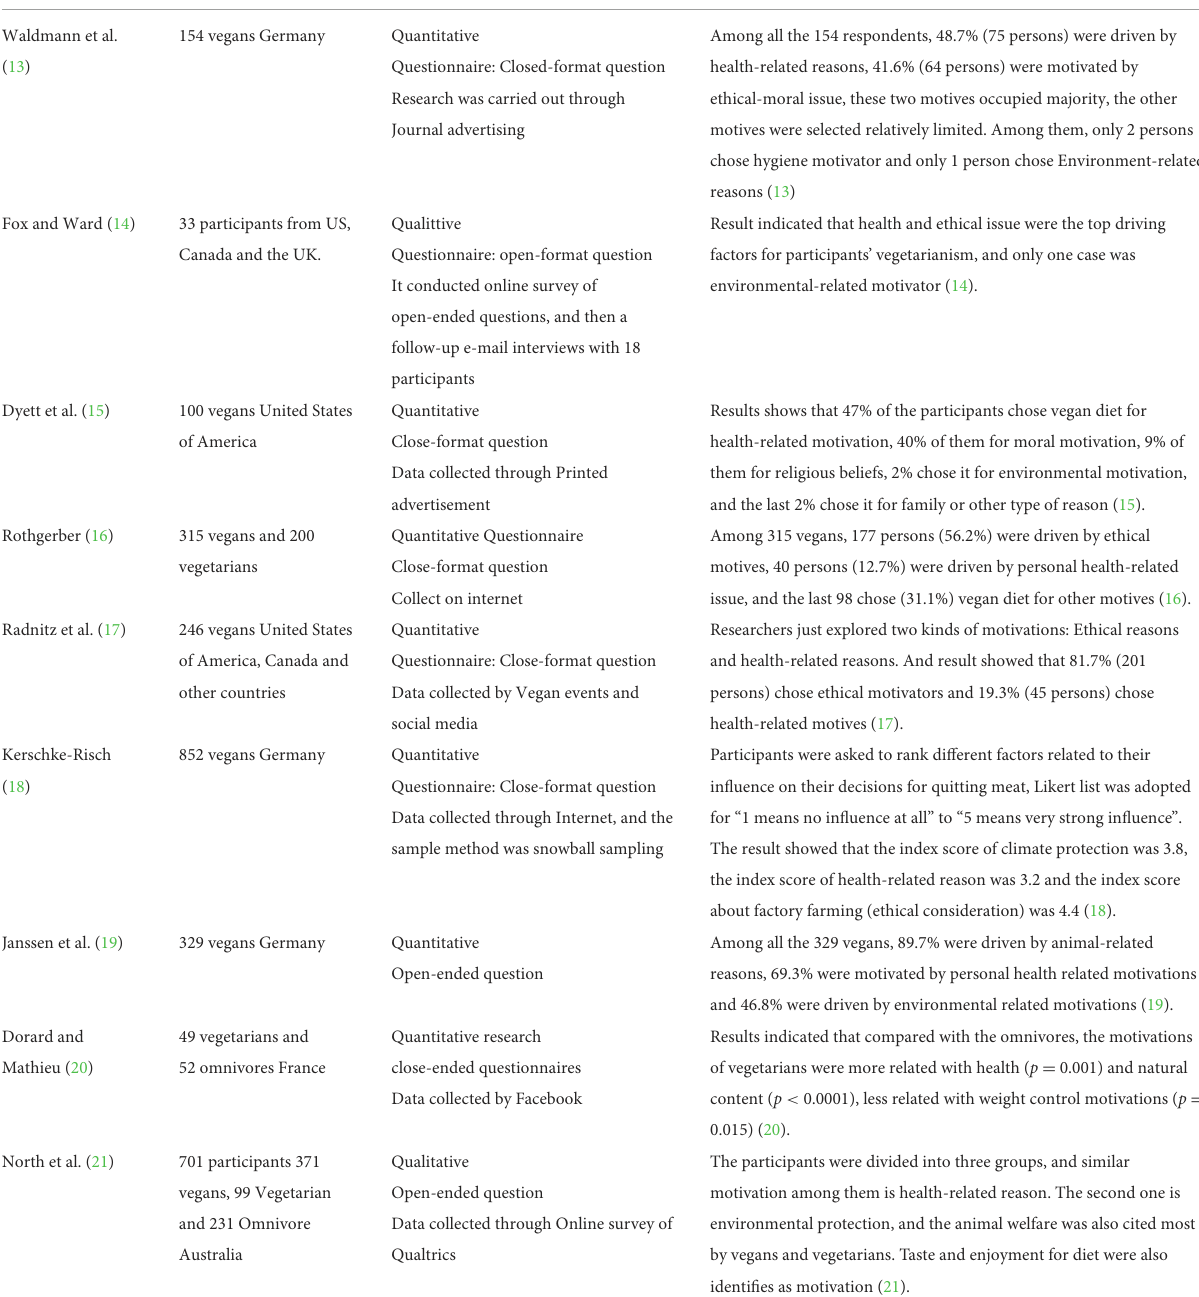
TABLE 1 List of previous researches on the benefits and motivations of vegetarian